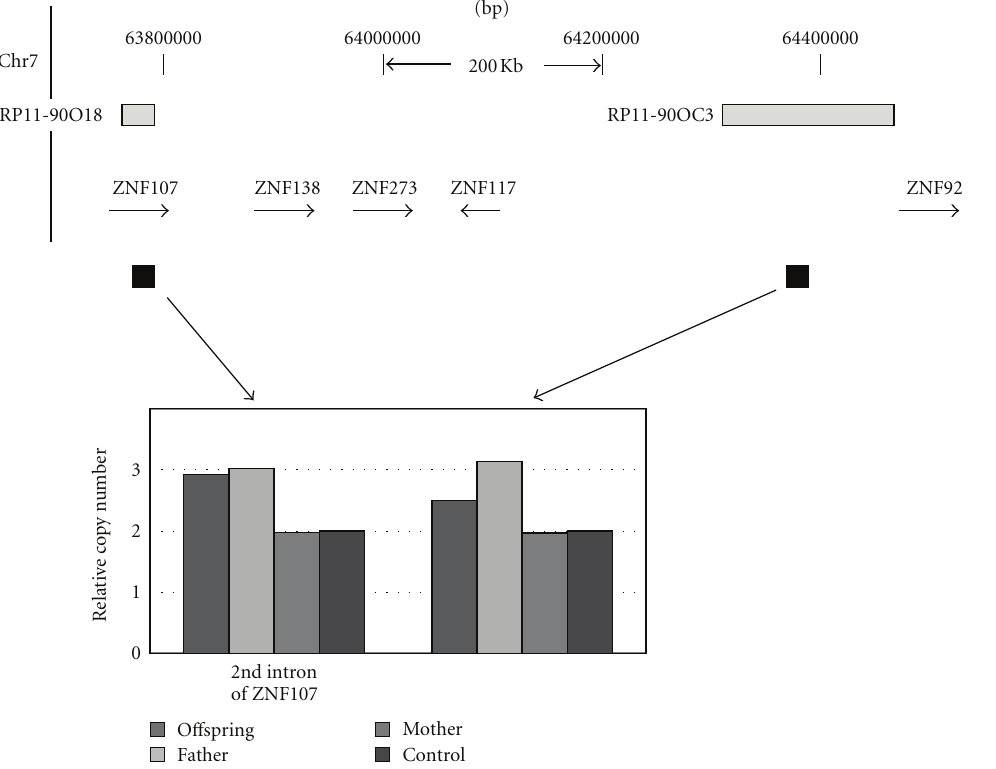
Figure 3: Characterization of a gain-type CNV detected on a BAC-clone RP11-90O18 and RP11-90C3. A genome map of both RP11-90 O18- and RP11-90C3-containing regions was obtained from the UCSC Genome Browser website. The distance (bp) from the p-terminal of chromosome 7 is shown in the uppermost part. That region contains zinc finger print protein gene families, that is, ZNF 107, 138, 273, 117, and 92 . The positions of PCR primers examined are shown by the solid